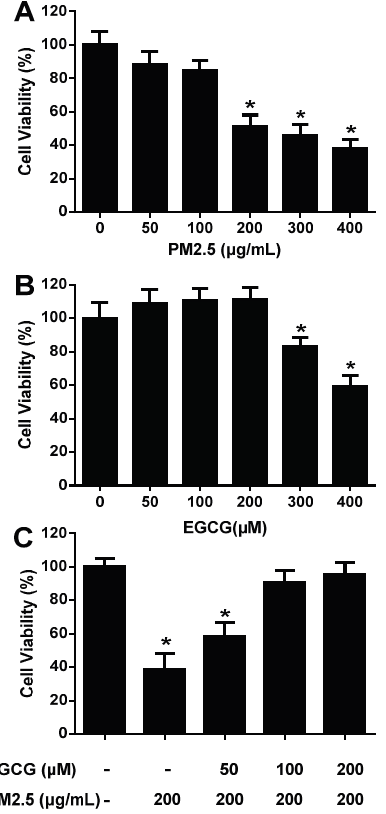
Figure 2. EGCG prevents PM 2.5 -induced reduction of HUVEC viability. Cell viability